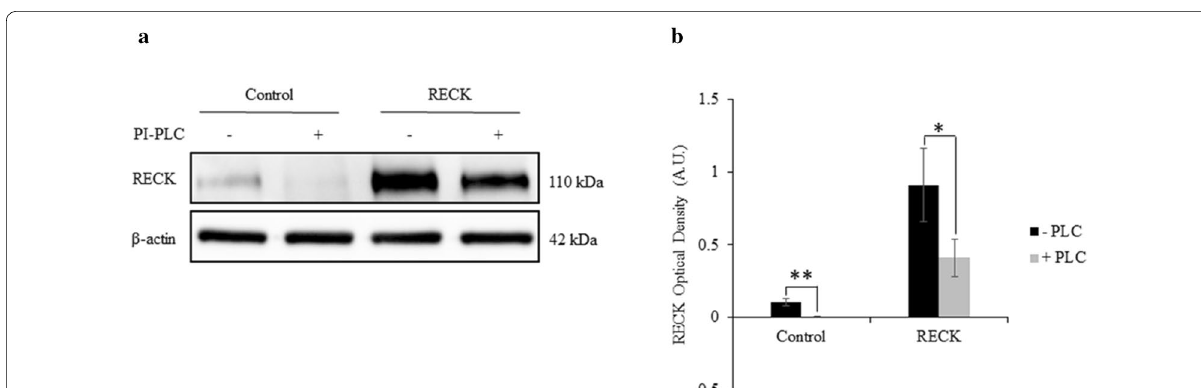
Fig. 5 Solubilization of RECK proteins following PI-PLC treatment. a Twenty-four hours following transfection of RECK constructs, control and transfected A6 cells were treated with PI-PLC for 24 h and cell lysate collected and analyzed by Western blot. b Densitometry quantification demonstrates that the level of RECK proteins bound to the cell is significantly reduced following PI-PLC treatment in both mock-transfected and RECK-transfected cells. β-actin is used as a loading control. Graphed data is based on 3 biological replicates (mean *,